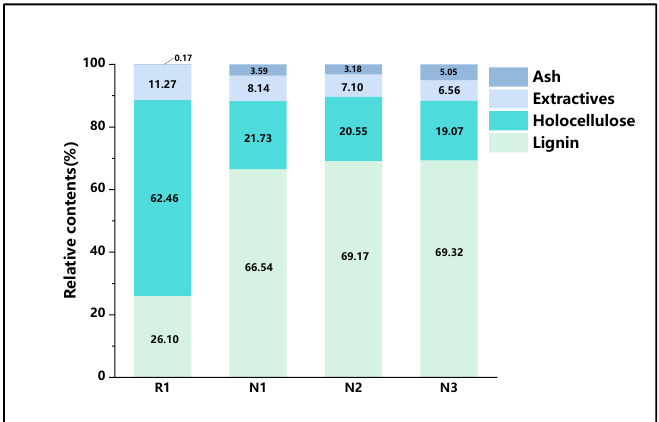
Figure 7. Relative contents of lignin, holocellulose, alcohol-benzene extractives, and ash of the archaeological wood.